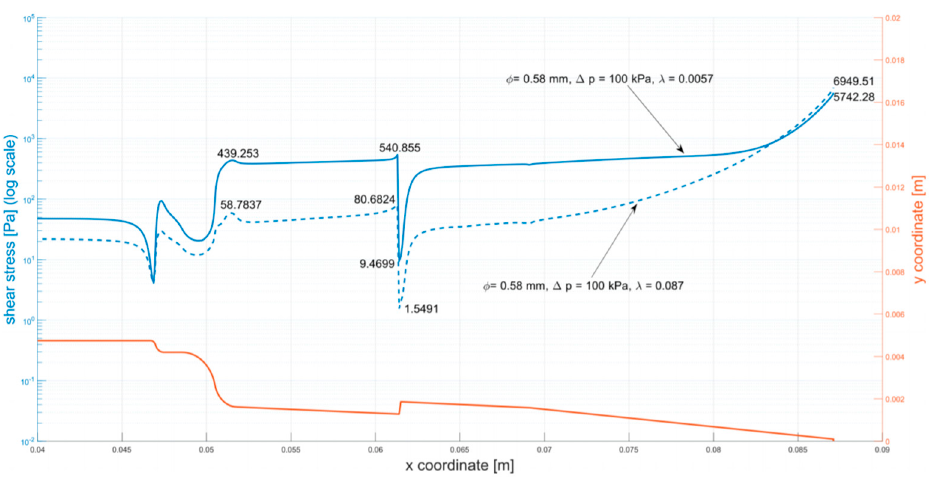
Figure A5. Shear stress at the walls of the cartridge ( φ = 0.58 mm, ∆ p = 100 kPa).